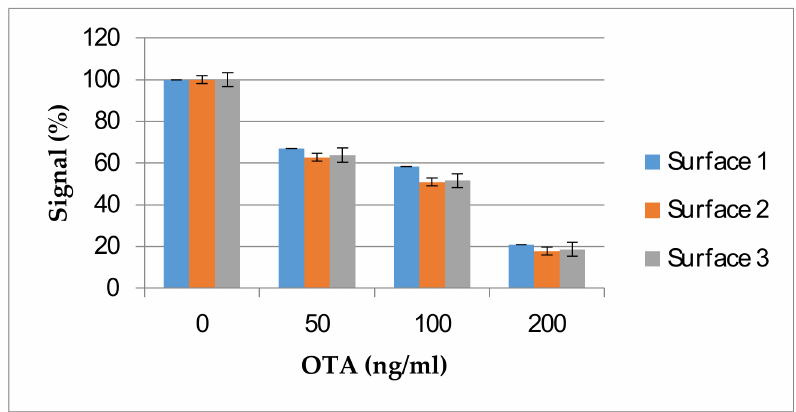
Figure 9. Repeatability of different sensors in terms of percent signal. Error bars represent standard